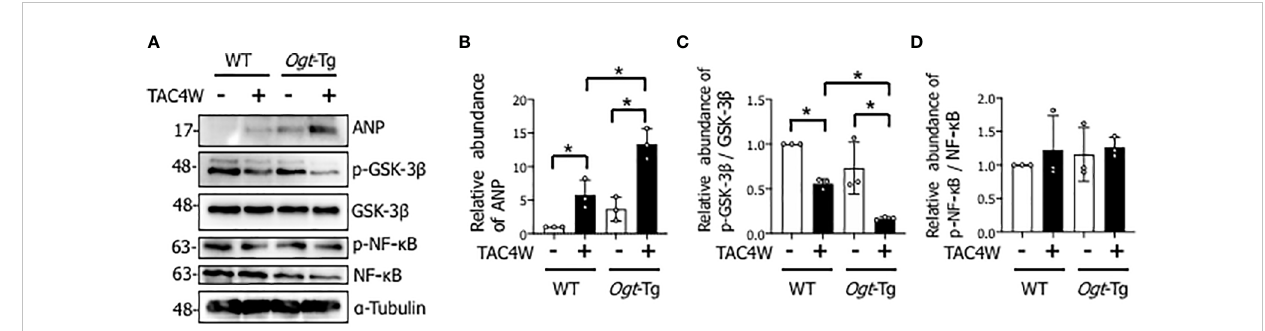
FIGURE 3 Decreased phosphorylation of GSK-3 b in the hearts of Ogt-Tg mice after TAC4W. (A) Western blot analysis for ANP, GSK-3 b phosphorylation, and NF- k B phosphorylation in heart tissues from WT and Ogt-Tg with or without TAC4W. Representative data was designated. (B) Quanti fi cations of ANP levels in (A) from three independent experiments using ImageJ software, and evaluated by two-way analysis of variance (ANOVA) followed by Tukey ’ s test. Values are shown as mean ± SD (n=3). *P<0.05. (C) The ratios of p-GSK-3 b /GSK-3 b expression intensity were quanti fi ed using ImageJ software, and evaluated by two-way analysis of variance (ANOVA) followed by Tukey ’ s test. Values are shown as mean ± SD value (n=3). *P<0.05. (D) The ratios of p-NF- k B/NF- k B expression intensity were quanti fi ed using ImageJ software, and evaluated by two-way analysis of variance (ANOVA) followed by Tukey ’ s test. Values are shown as mean ± SD value (n=3). TAC, transverse aortic constriction; ANP, atrial natriuretic peptides.